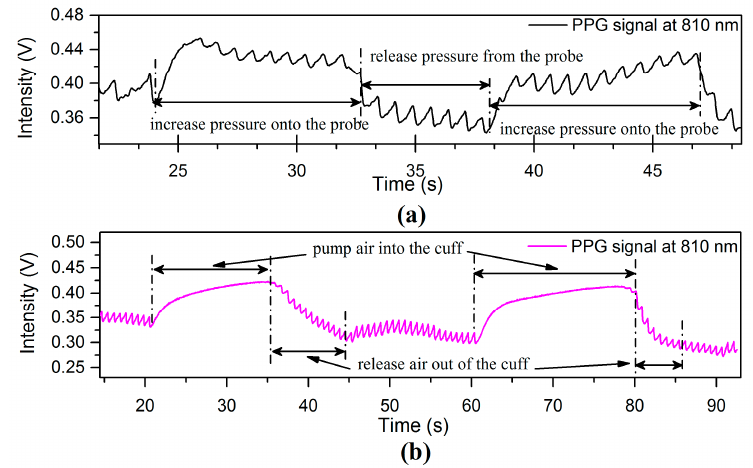
Figure 15. The PPG signal affected by local BP variations at the measuring site due to ( a ) external pressure applied on finger probe and ( b ) external pressure applied on wrist by processing the inflatable-cuff type blood pressure monitor.